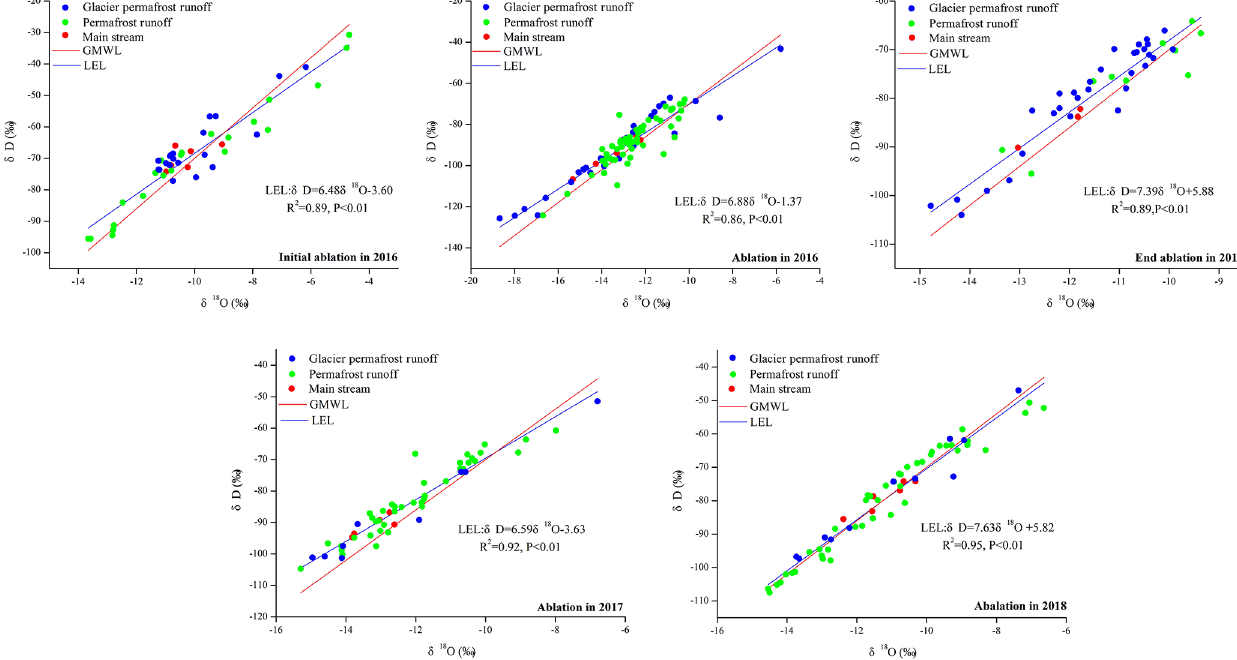
Figure 6. The variation in location evaporation line (LEL) of river water based on different ablation in 2016 and ablation from 2016 to